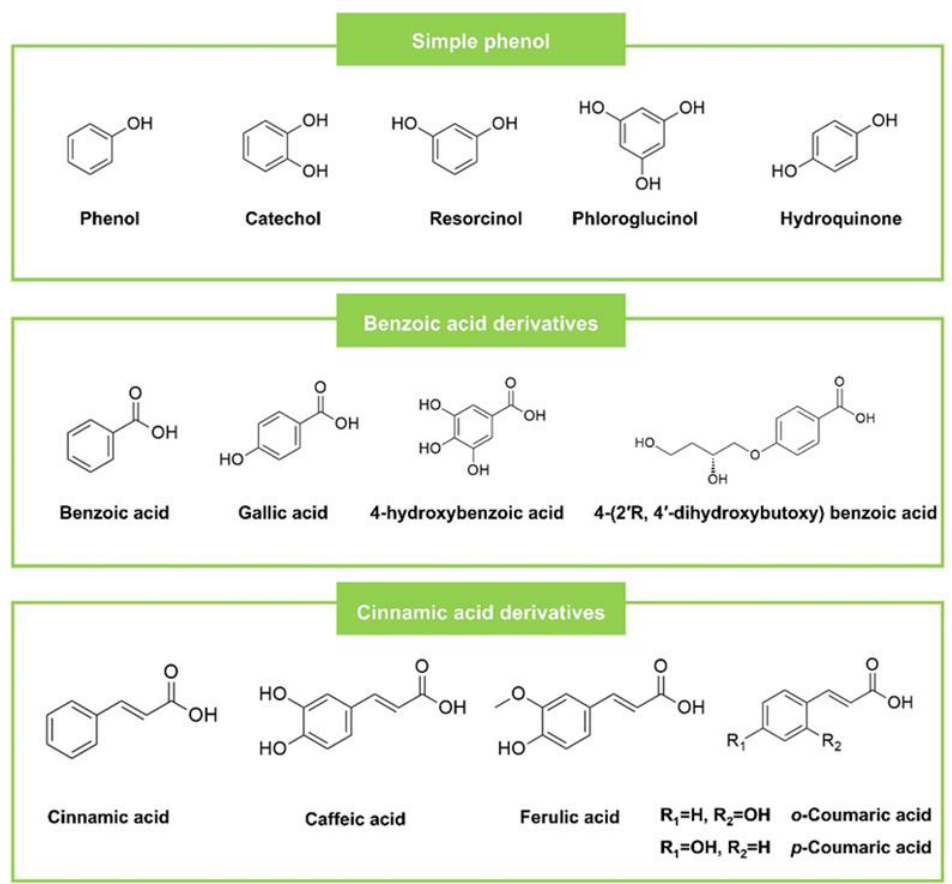
Figure 1. Representative chemical structures of simple phenol, benzoic acid derivatives and cinnamic acid derivatives.